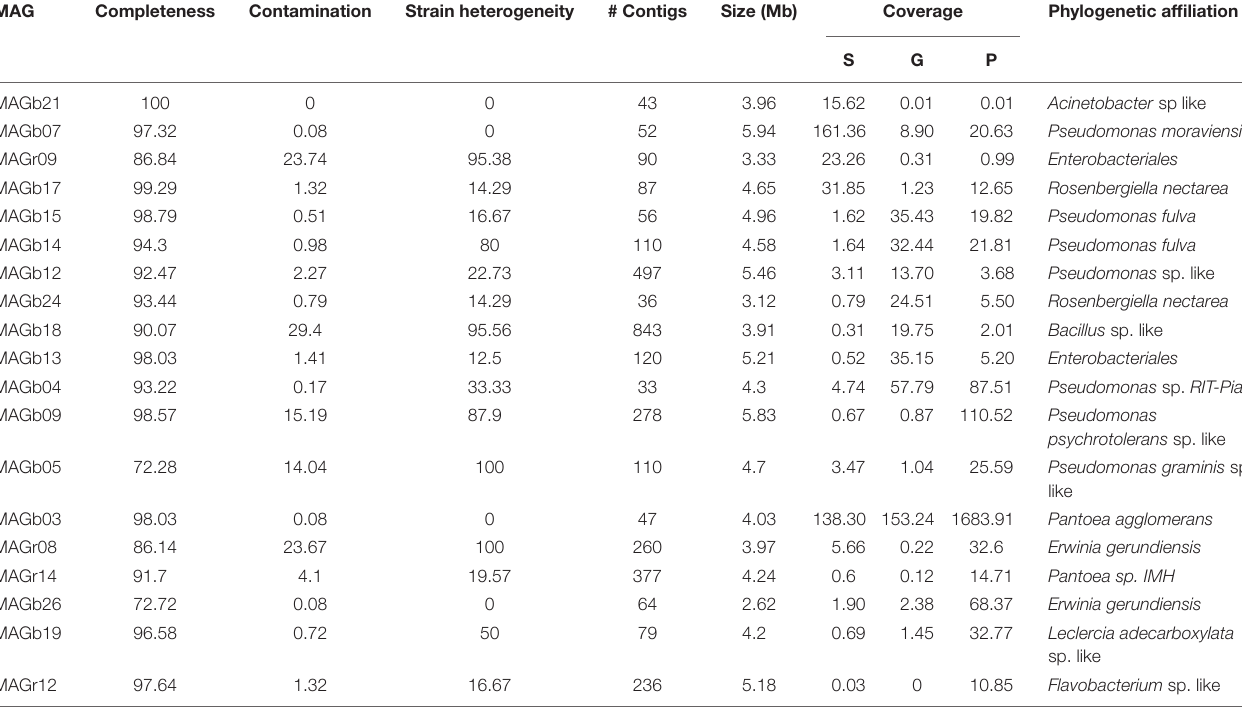
TABLE 1 | General statistics of the 19 draft metagenome-assembled genomes (MAGs) reconstructed from bean and radish metagenomes.